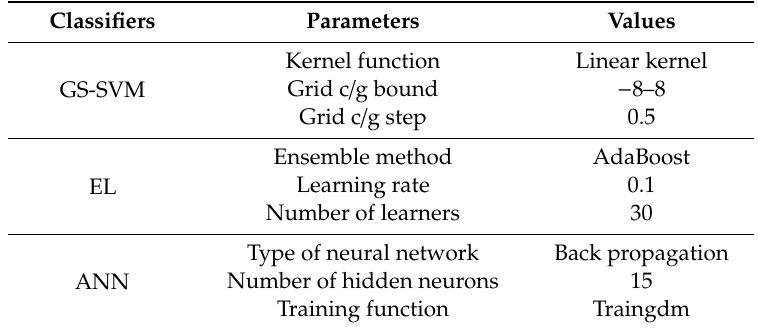
Table 4. Parameter settings of classifiers.